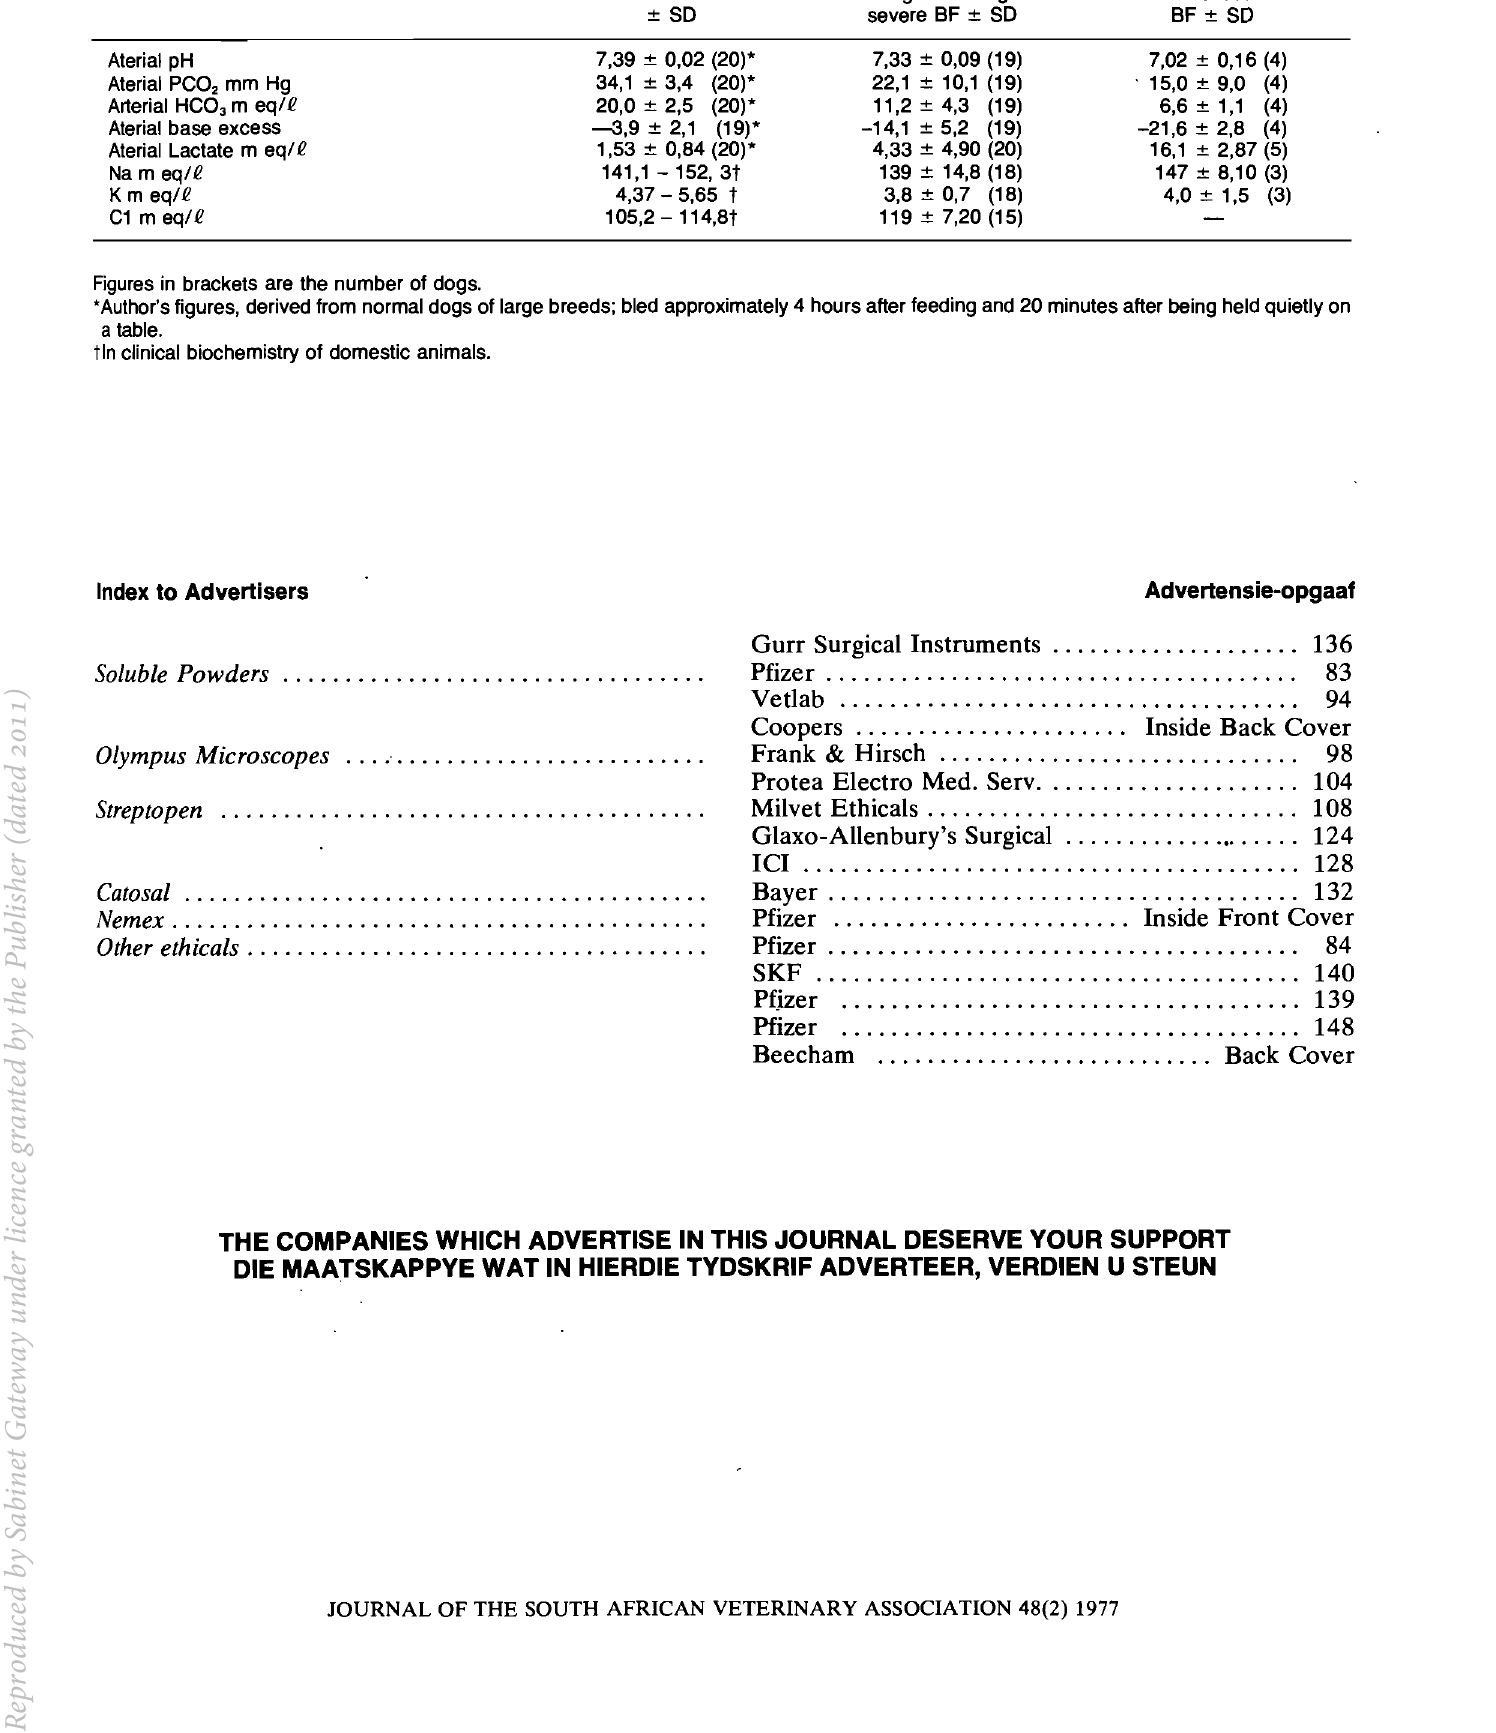
Table 1: ACID BASE PARAMETERS AND SERUM ELECTROLYTES IN NORMAL DOGS, DOGS SURVIVING SEVERE BF AND FATAL CASES OF BF